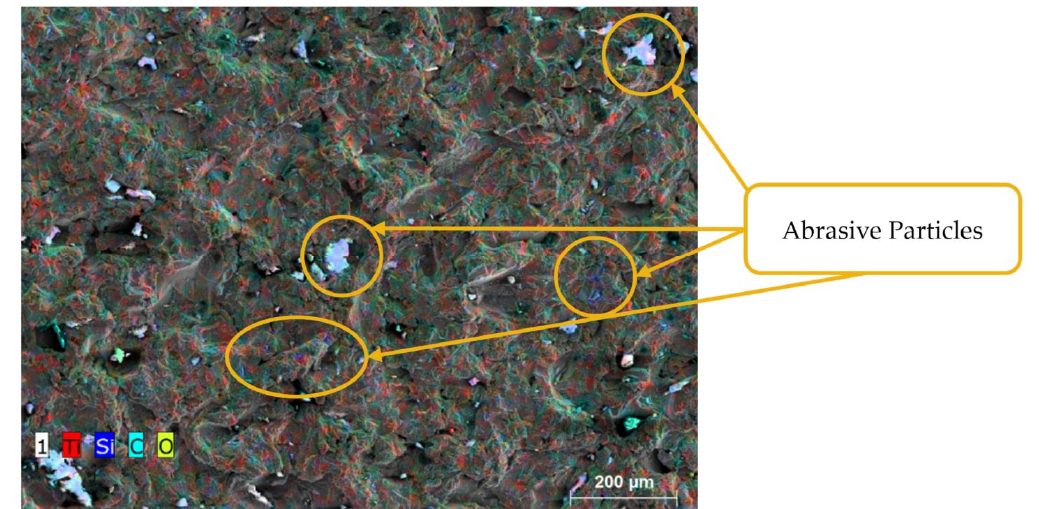
Figure 3. Remains of abrasive particles adhered to the surface after texturing.